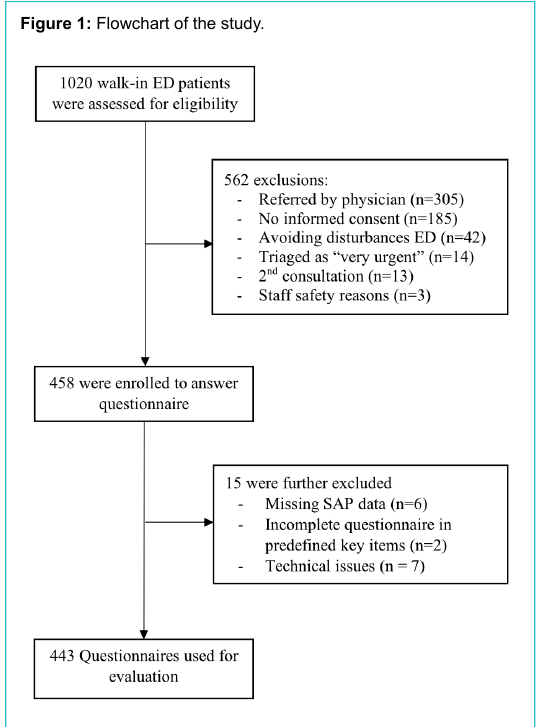
Figure 1: Flowchart of the